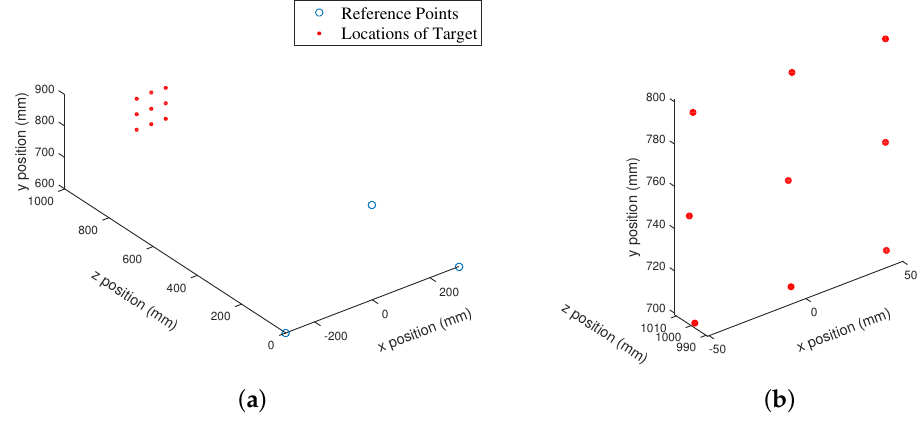
Figure 7. ( a ) A test case from the experimental results that represents the positioning of transmitters and receivers; and ( b ) zoomed version of the position of the